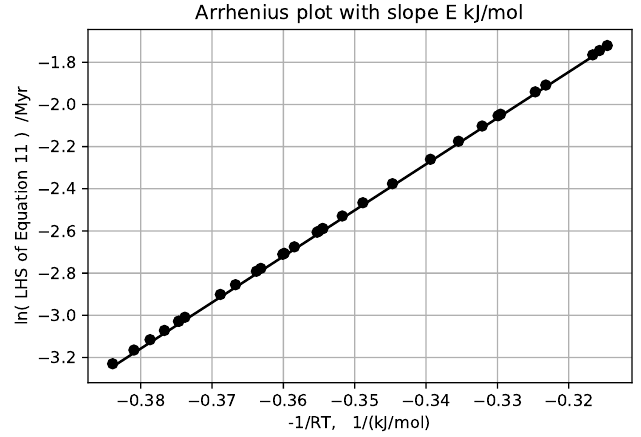
Figure 24. Maracaibo −